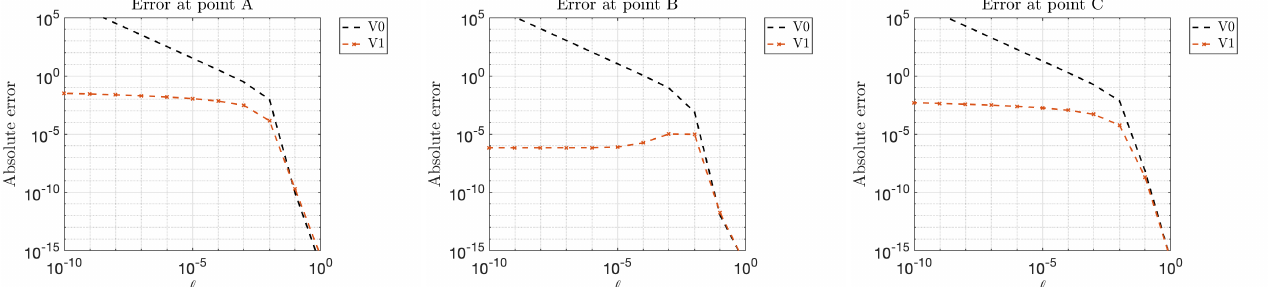
Figure 6. Helmholtz 2D. Plots of log of the error for the evaluation of the solution of (18) out of 10 the star domain defined by the boundary y ( t ) = ( 1 + 0.3cos5 t ) ∗ ( cos t ,sin t ) , t ∈ [ 0,2 π ] , for the using PTR with N = 256.